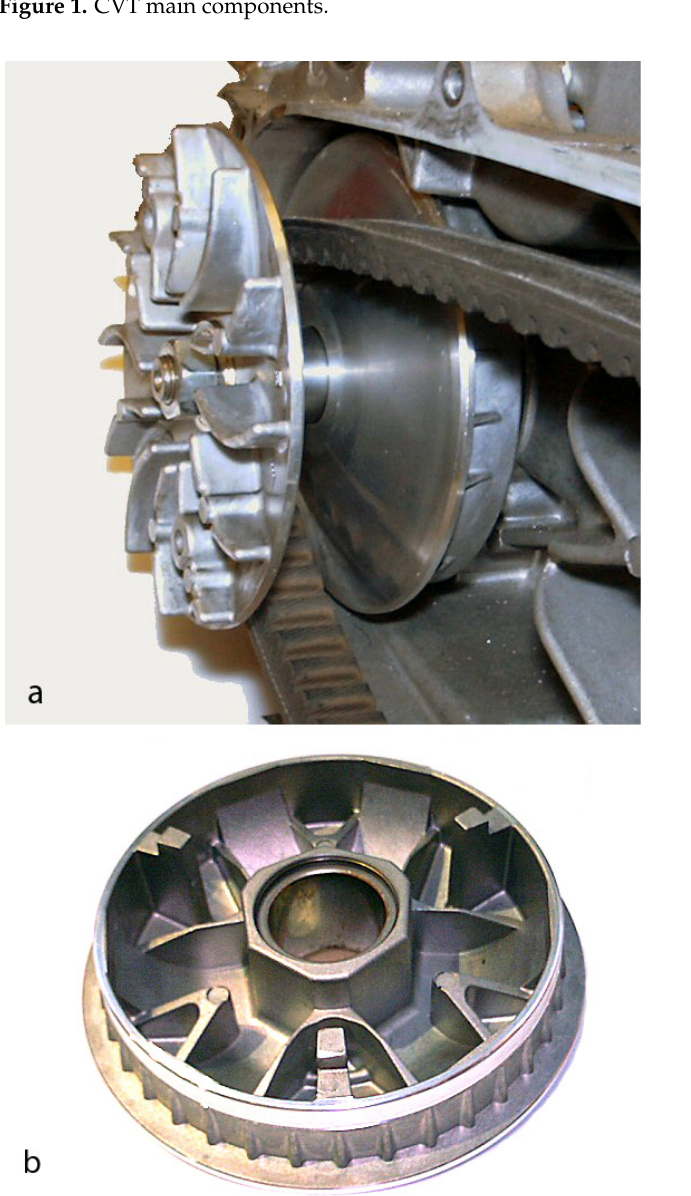
Figure 2. Images of the two half-pulleys and V-belt ( a ) and the front half movable pulley inner part ( b ).